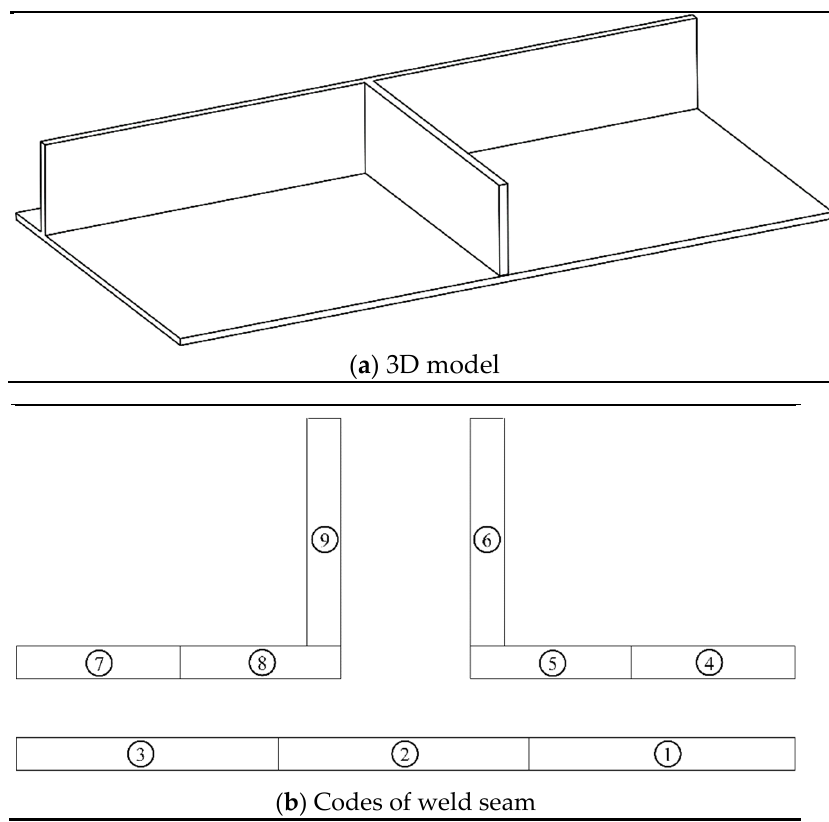
Figure 8. Weld seam coding of welded structure 2.